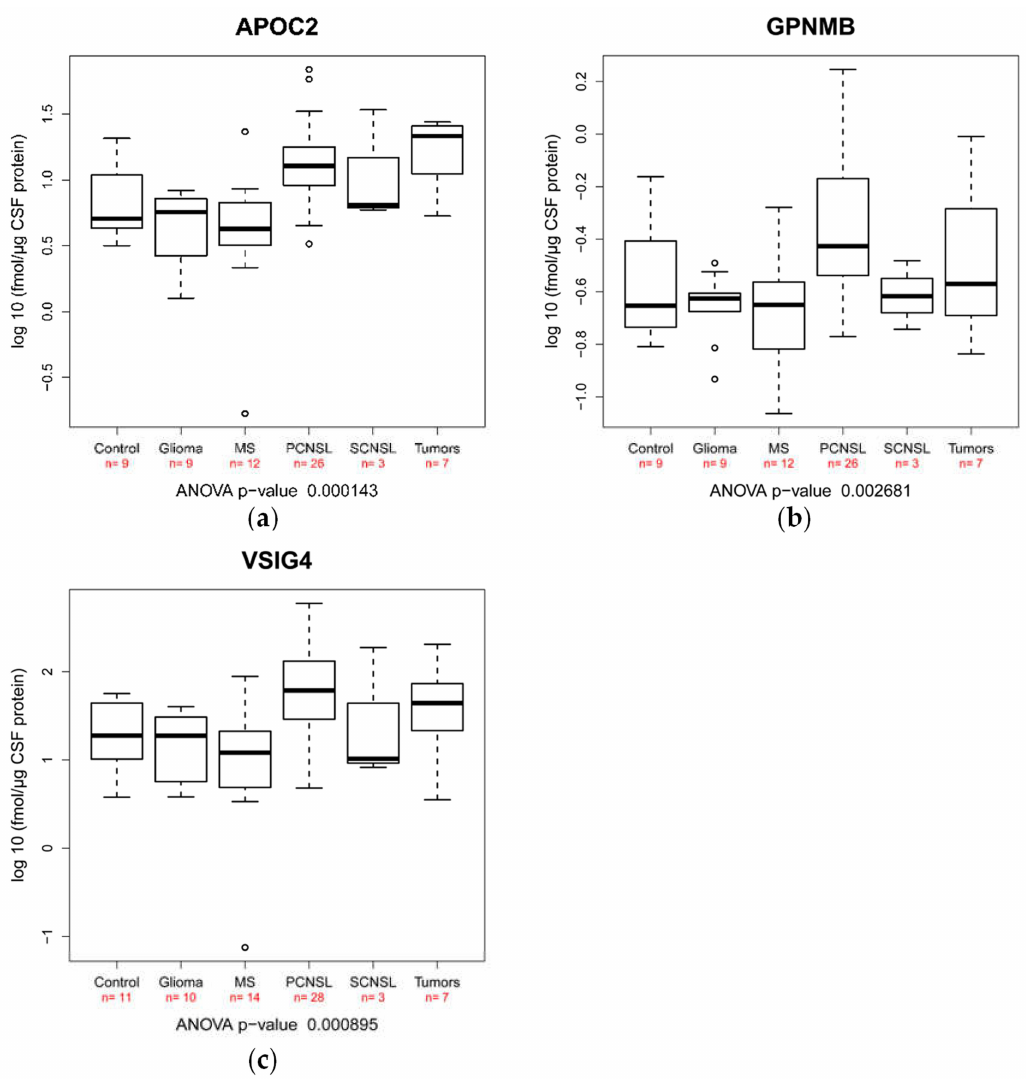
Figure 3. Boxplots of the candidate biomarker peptides’ concentration, using SRM-based absolute quantification on the concentration of candidate biomarker peptides: ( a ) APOC, ( b ) GPNMB and ( c ) VSIG4. Boxes include 50% of all values for the respective group and the black bar in the box represents the median value of log 10 concentration values. The end of the upper whiskers represents the smallest value of the maximum value and maximum upper quartile plus 1.5*inter quartile range (IQR) (min(max(x), Q_3 + 1.5 * IQR)); the end of the lower whisker represents the larger value of the minimum value and minimum lower quartile minus 1.5xinter quartile range (max(min(x), Q_1 – 1.5 * IQR)). The number of valid values for each group and peptide / protein is